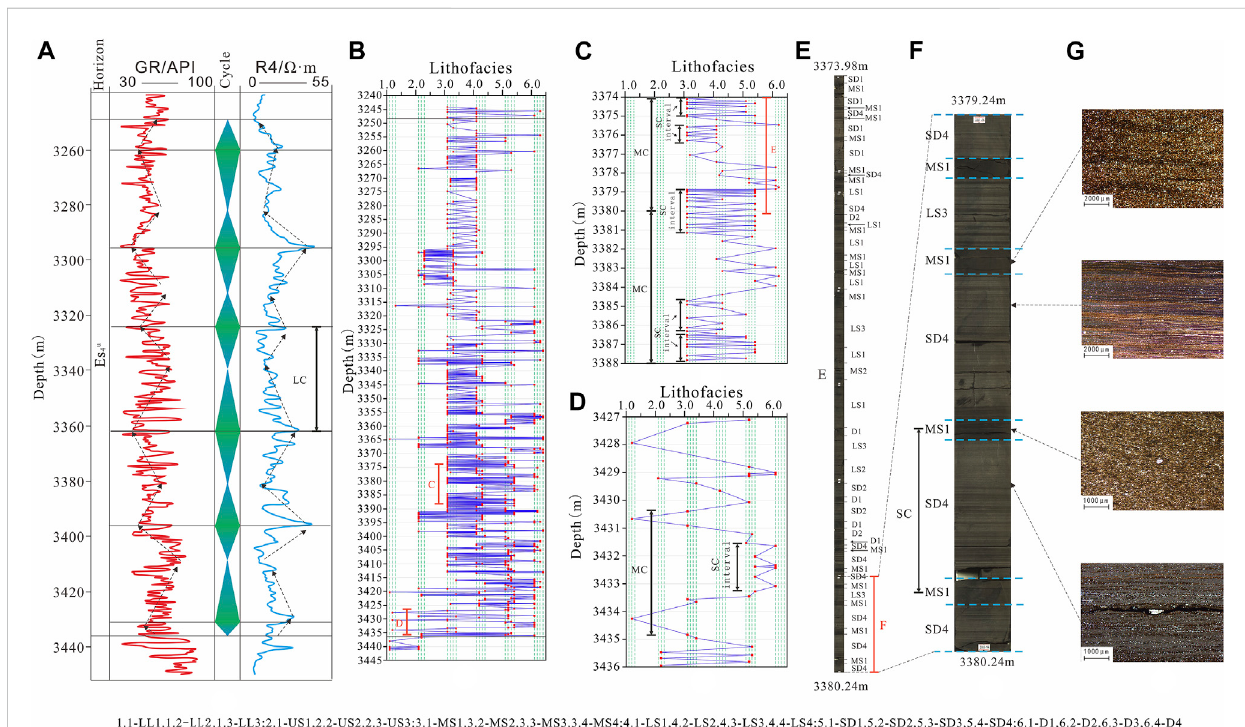
FIGURE 3 Different scales of lithofacies cycles in Es 4 u in Boxing Subsag: large-scale lithofacies cycle (A) , vertical lithofacies change (B) , typical mesoscale lithofacies cycle (C – E) , typical small-scale lithofacies cycle (F) and thin-section Images in F (G)